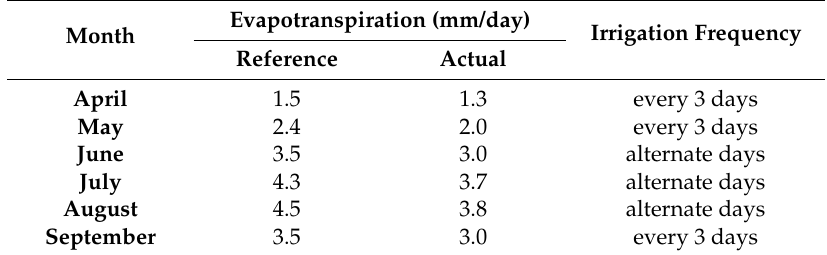
Table 2. Potential and actual evapotranspiration (mm/day) and the irrigation frequency for each month of garden irrigation with harvested